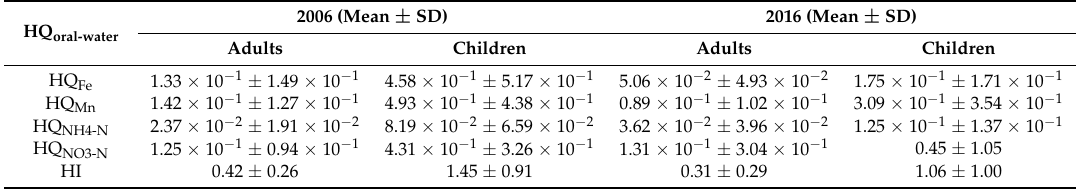
Table 7. Assessment results of health risks for adults and children through drinking water intake.